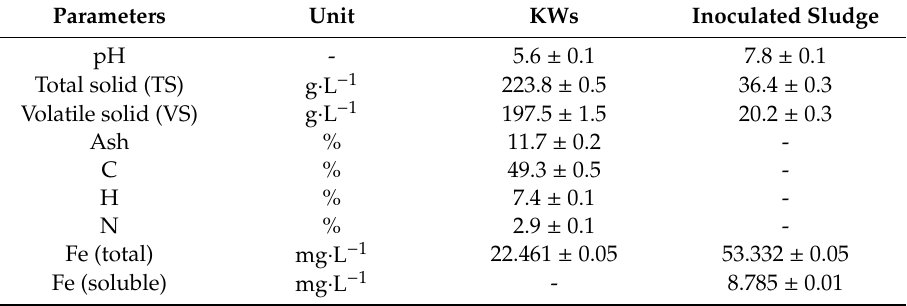
Table 1. Chemical characteristics of KWs and inoculated